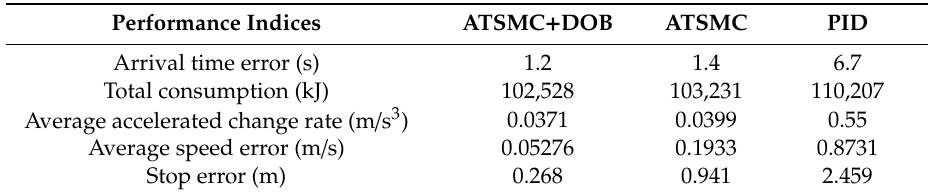
Figure 23. Experiment 3 and Experiment 4. Table 9. Detailed data about the